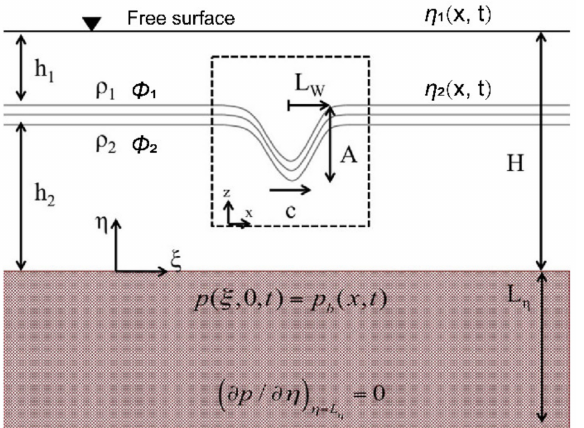
Figure 3. Typical definition sketch of a two-layer fluid system for a depression ISW propagating over a flat seabed. The seabed thickness L η , the ISW amplitude A , half-wavelength L w , and a phase speed c are also shown. The ISW lies in a reference frame, x – z , that moves with the wave. The